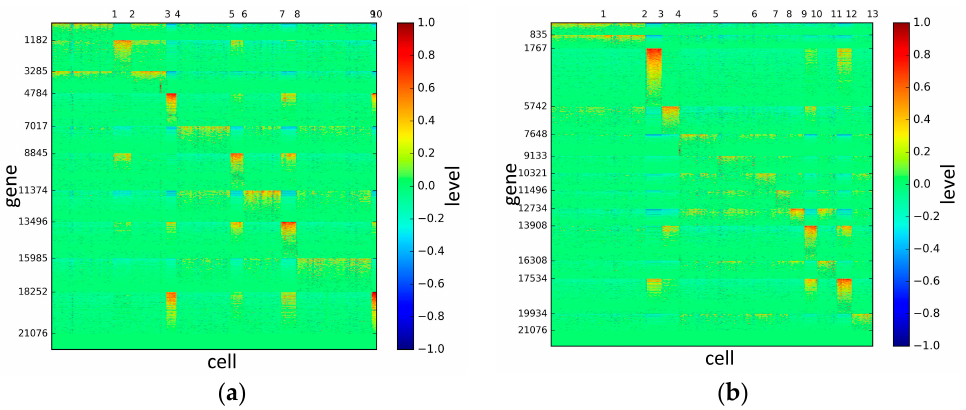
Figure 3 . The heat maps of Yan datasets.